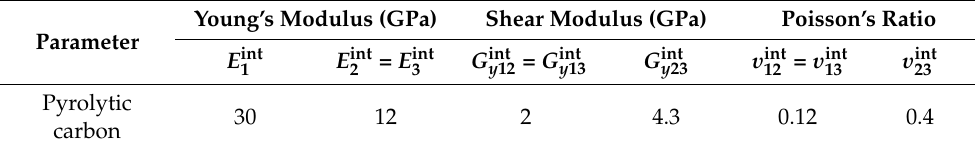
Table 4. Mechanical properties of the coating [30] (Reprinted/adapted with permission from Ref. [30]. 2009,